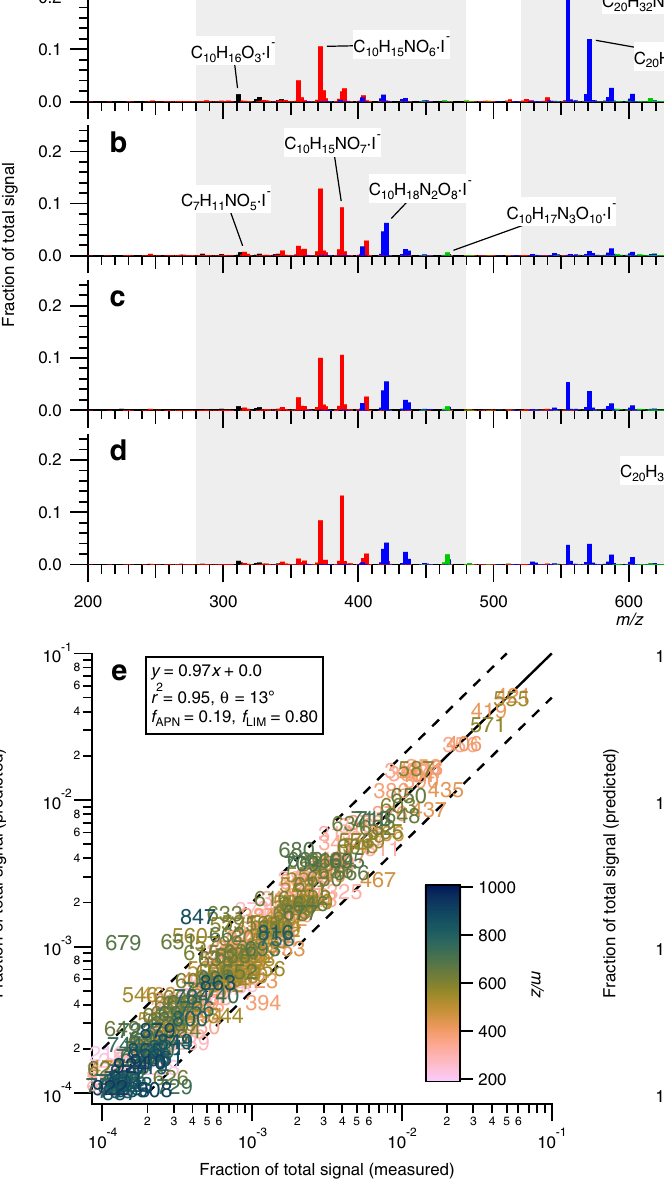
Fig.2|Massspectraofa fi lterinletforgasesandaerosolscoupledtoachemical ionization mass spectrometer (FIGAERO-CIMS)and their comparison between single- and multi-precursor systems. FIGAERO-CIMS mass spectra in a pure α - pinene (APN), b pure limonene (LIM), c sequential oxidation (SEQ), and d simultaneous oxidation (MIX) experiments, colored by the number of nitrogen atomsintheassignedmolecularformulae.Monomer,dimer,andtrimerregionsare shaded. Comparison of the mass spectra observed in e SEQ and f MIXexperiments